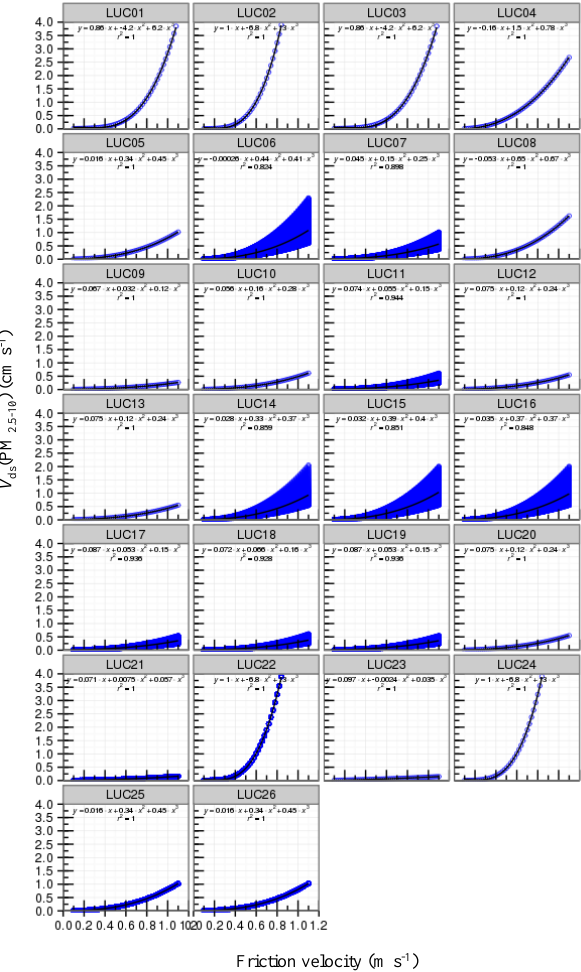
Fig. 2. A comparison of V d (PM 2 . 5 ) between the new and the origi- nal scheme for the 26 LUCs. Solid lines represent regression equa- tions, and circles represent data points.